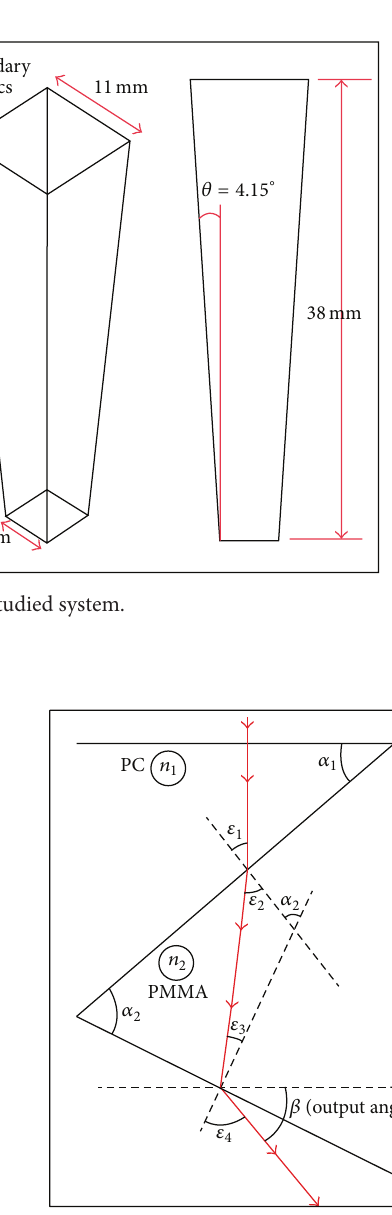
Figure 4: Ray refraction across achromatic